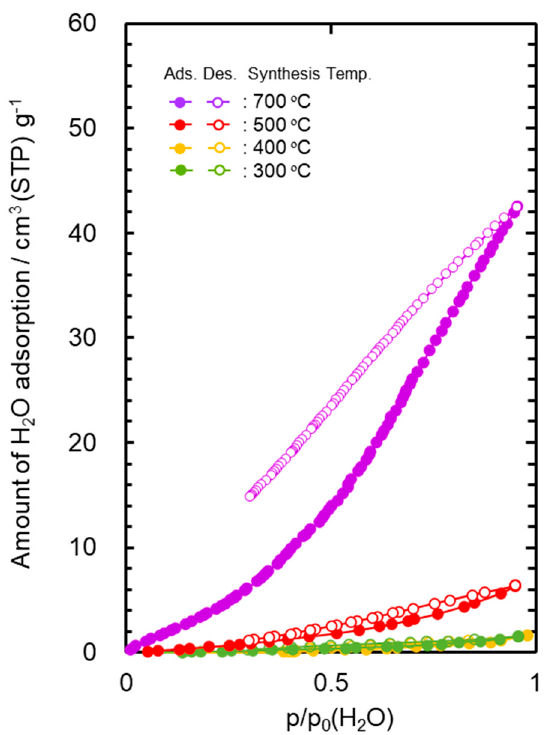
Figure 2. Water vapor adsorption–desorption isotherms at 25 °C for SiCH inorganic–organic hybrid powder samples synthesized by heat treatment of AHPCS at 300–700 °C in